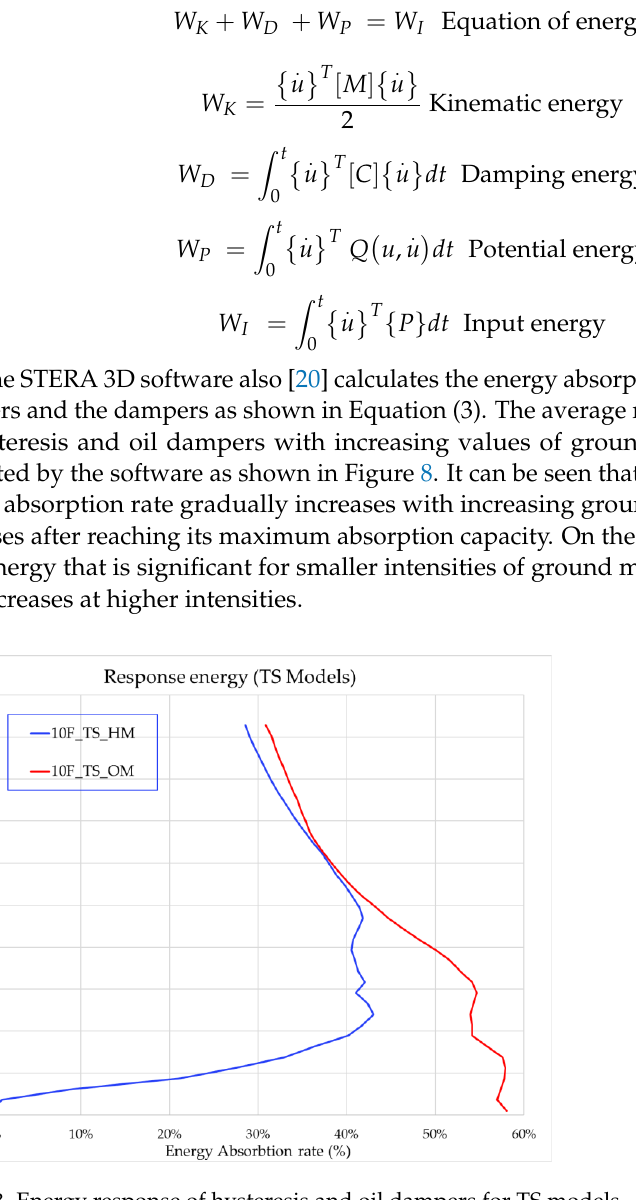
( b ) Figure 9. New combinations (dimensions in mm): ( a ) Hysteresis – Oil – Hysteresis Model; ( b ) Oil – Hysteresis – Oil Model.